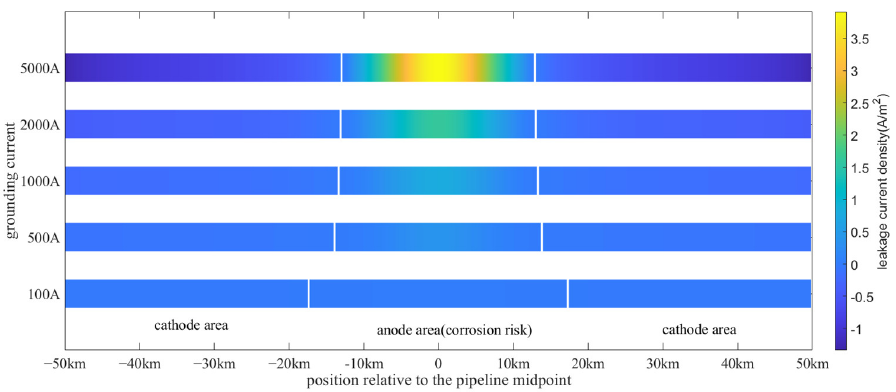
Figure 11. Corrosion risk area distribution under different grounding currents.